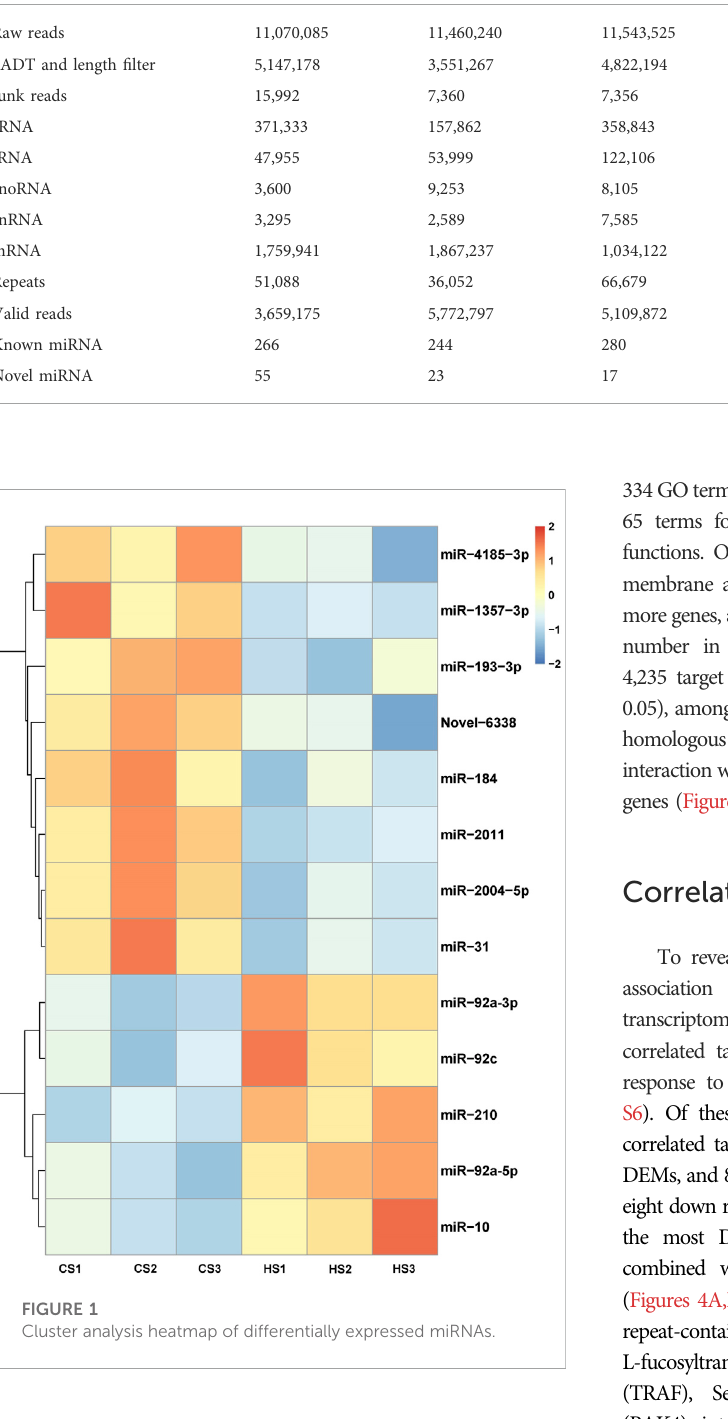
5,153 target genes of fi ve upregulated DEMs and 11,410 target genes of eight downregulated DEMs. The GO database annotation results showed that 11,001 target genes of 13 DEMs were annotated to